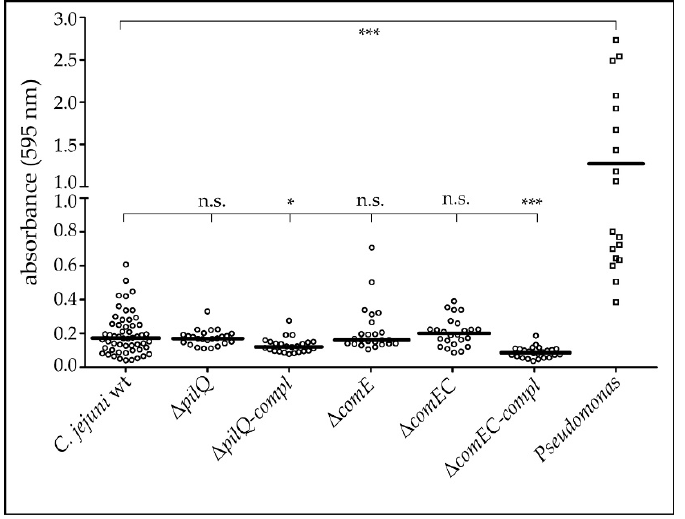
Figure 5 . Biofilm formation is independent of active DNA transport or natural transformation in C. jejuni . Upon growth in microtiter plates for 72 h and suitable washing of unbound bacteria, crystal violet staining indicated the intensity of biofilm formation, measured as absorbance at 595 nm. C. jejuni 81–176 (wt) and its isogenic mutants Δ pilQ , Δ comE , Δ comEC and the respective complemented strains were tested, using Pseudomonas aeruginosa as reference for a typical biofilm forming bacterium. Horizontal bar, mean of ≥ 3 independent experiments; n.s., not significant; *, p < 0.05; ***, p < 0.001.